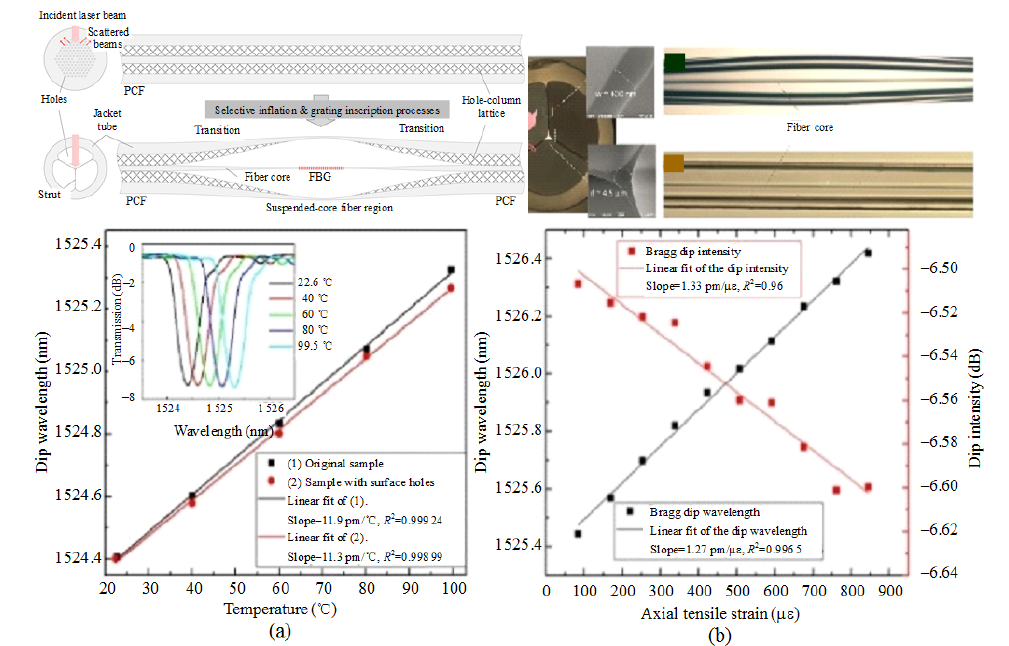
Fig. 4 Schematic diagram and micrograph of the FBG sensor based on the PCF and its temperature and strain response